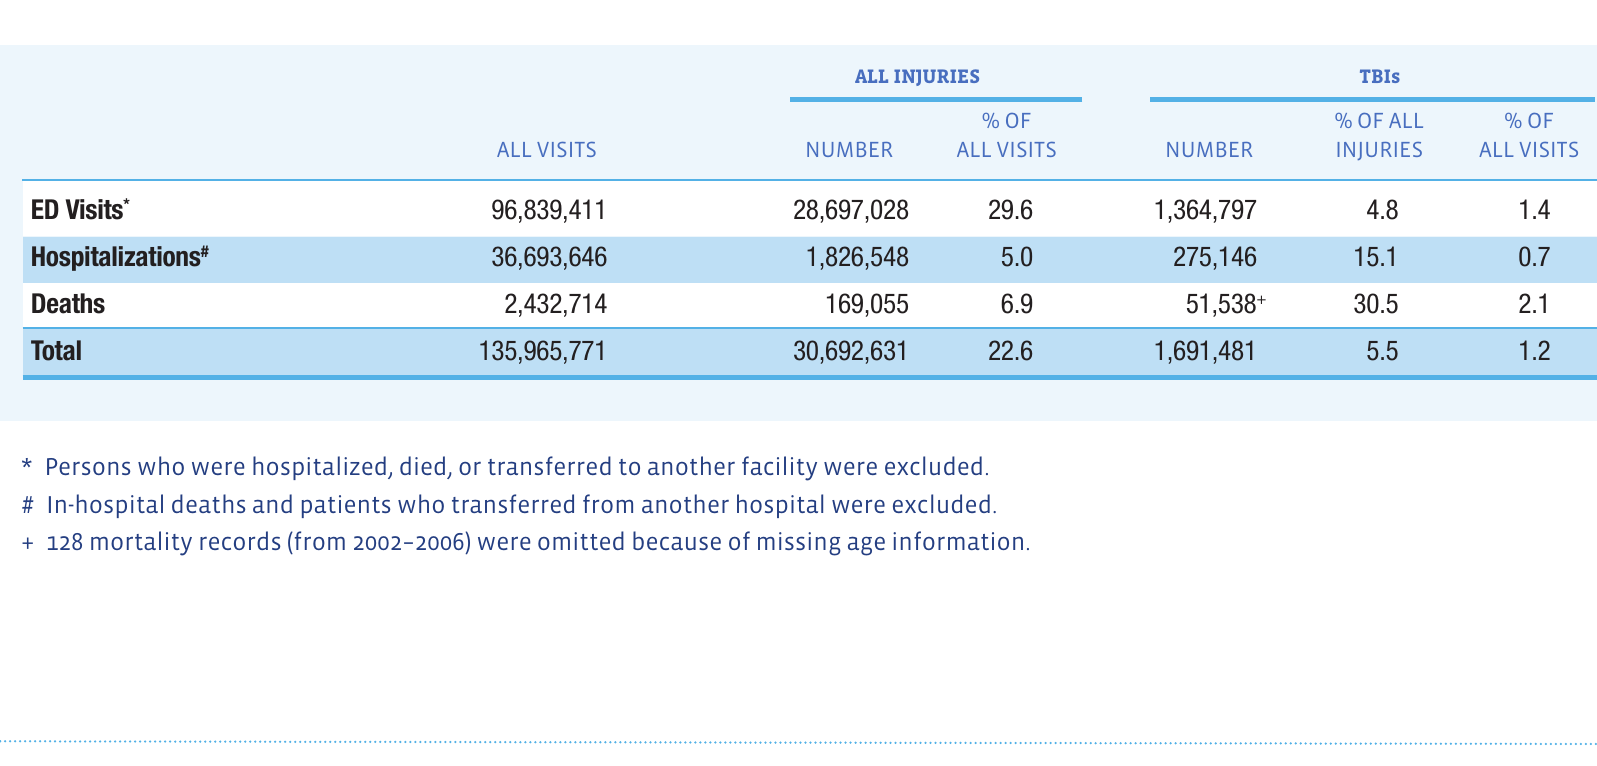
TABLE A: Estimated Percentage of All Injuries and Traumatic Brain Injury-Related Emergency Department Visits, Hospitalizations, and Deaths, United States,